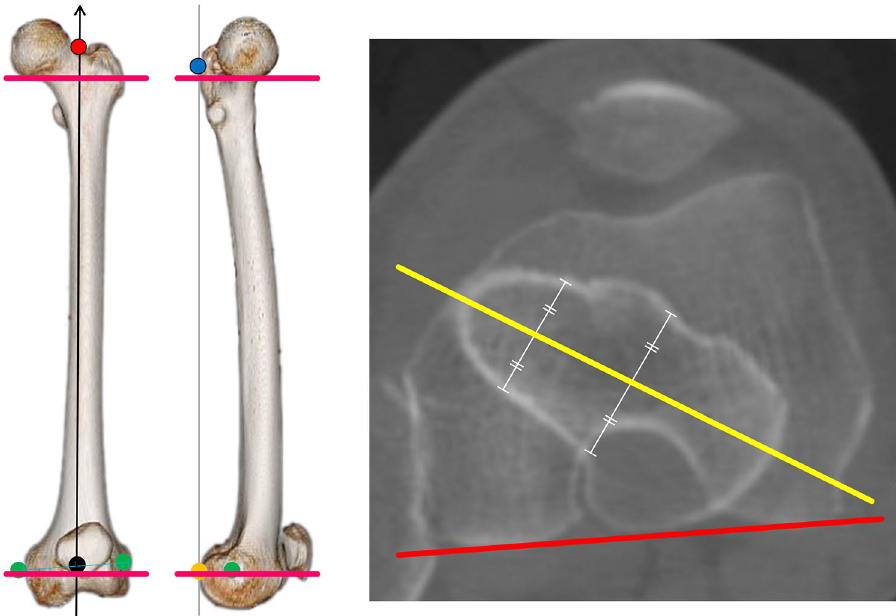
Figure 1. Native anteversion was determined using the method reported by Sugano et al. 9 . The coordinate system for the femur was defined relative to the posterior condylar plane of the femur, which was formed by the proximal posterior surface (blue point), lateral condyle, and medial condyle (yellow point) 10 . The z-axis was defined as a projected line onto the posterior condylar plane, passing through the knee centre (black point) and trochanteric fossa (red point). This method used the axial plane at the level just below the femoral head on the coronal plane to determine the neck axis without head centre. The angle between the neck axis (yellow line) and the posterior femoral condylar line (red line) was measured 9